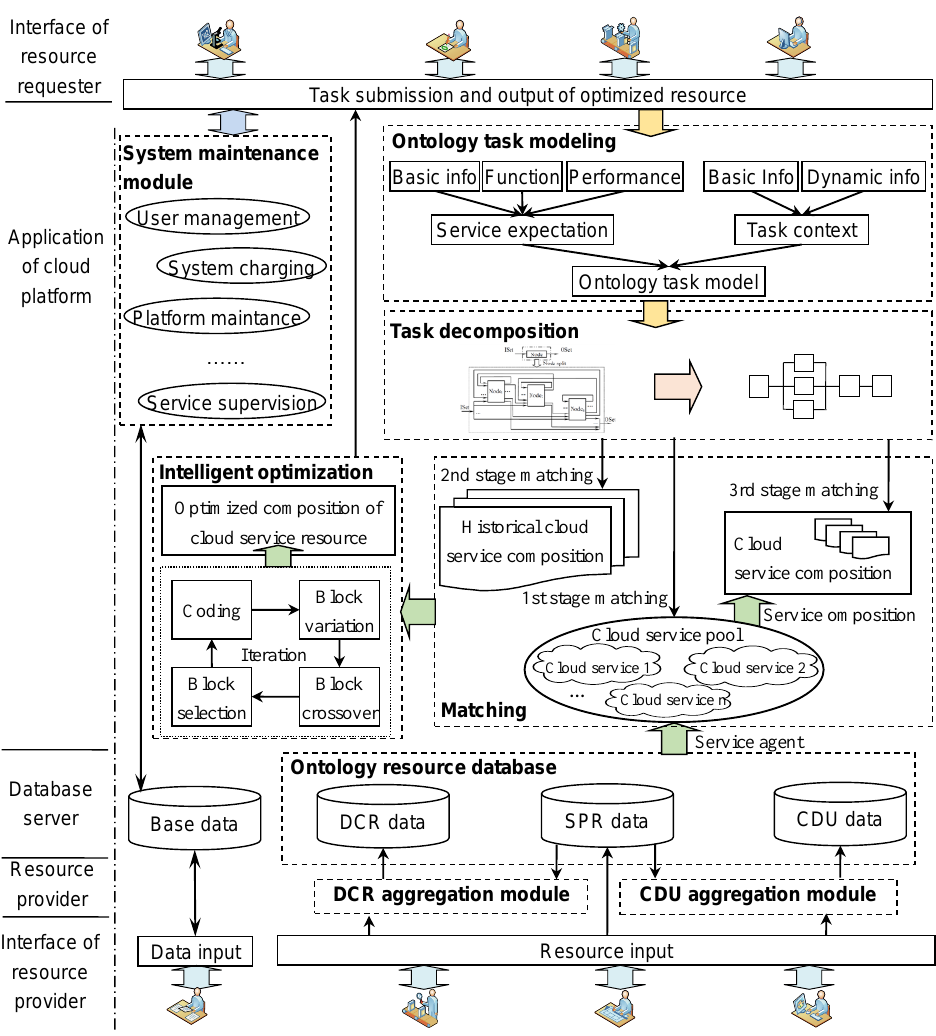
Figure 14. Architecture of CMfg system.